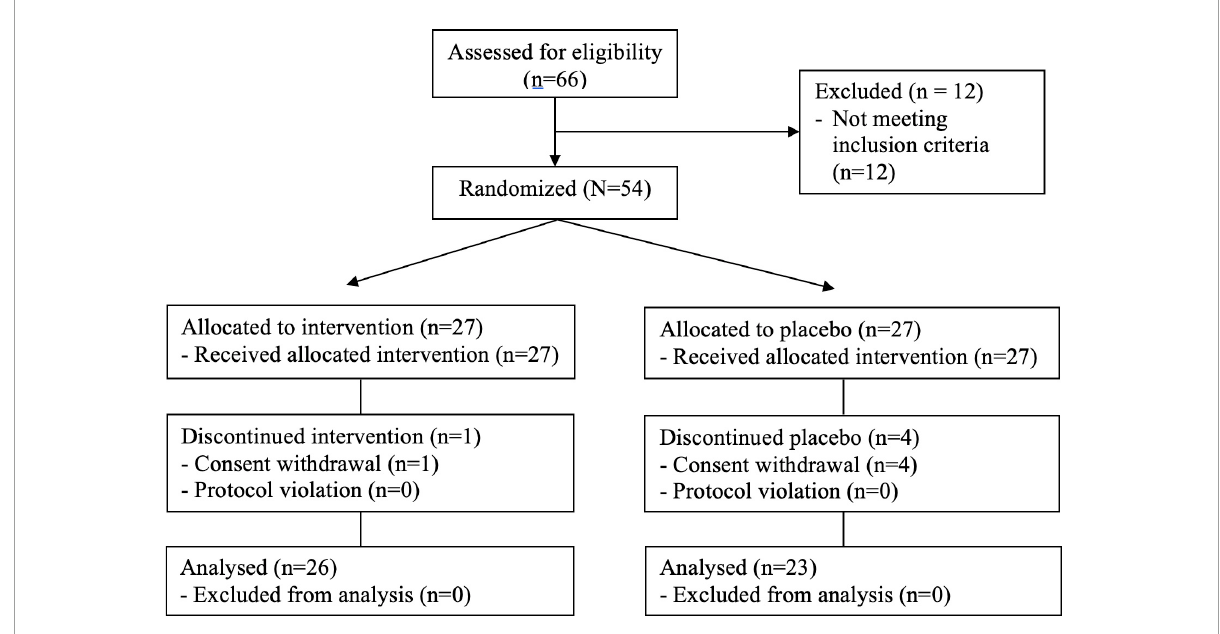
FIGURE1 CONSORT flow diagram.